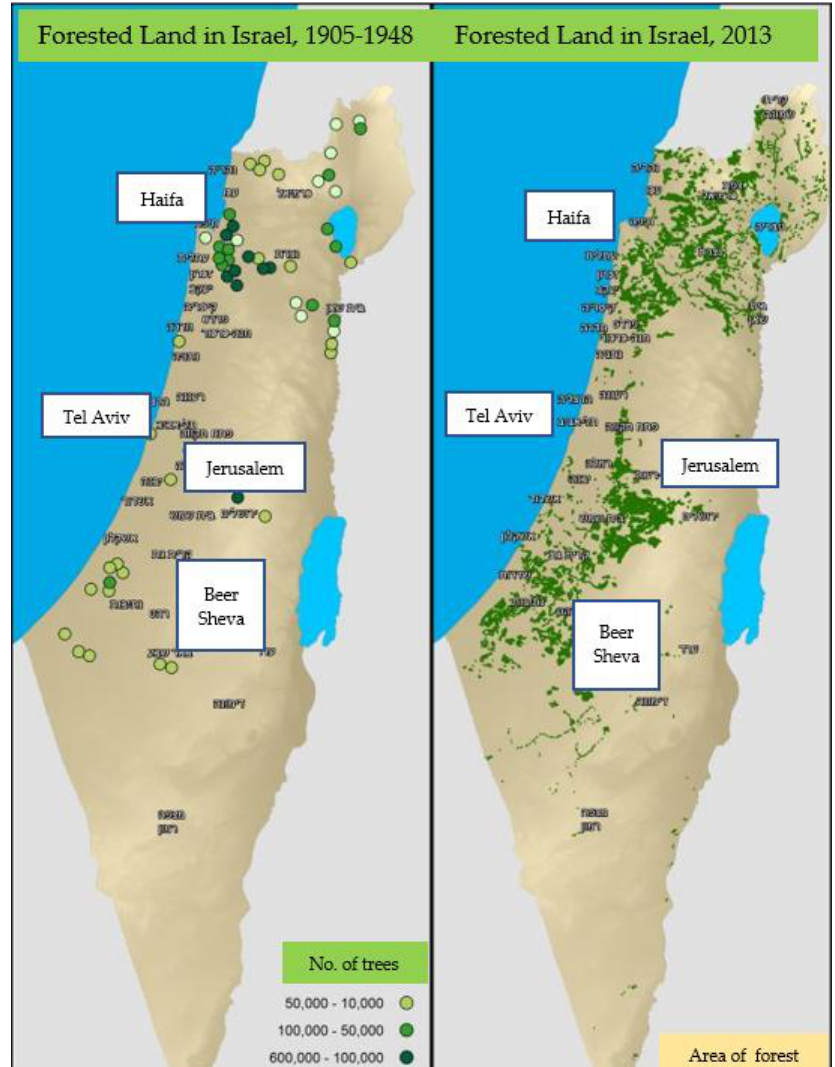
Figure 1. Forest expansion in Israel, 1905 to 2013. Source: DESHE, Israel Open Space Institute. Second, Israel’s forests have played a meaningful role in local political dynamics. While